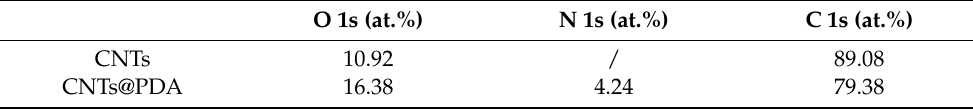
Table 1. Element content of CNTs and CNTs@PDA.